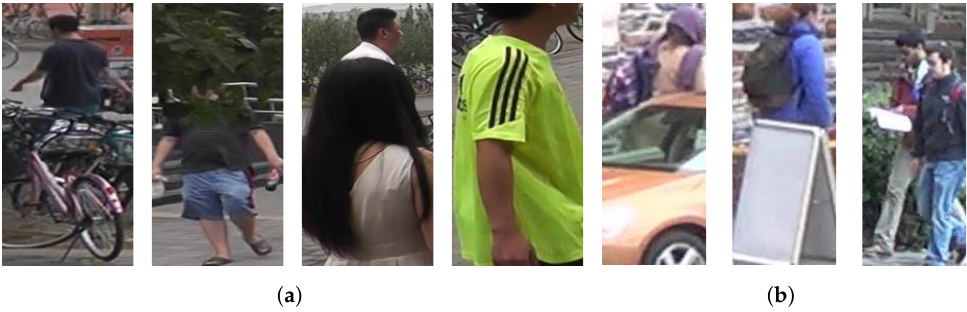
Figure 3. ( a , b ) represent the occlusion types in MARS and DukeMTMC-VideoReID datasets, respec- tively. Various occlusion types exist, such as a lower body or head of a pedestrian occluded by other pedestrians, tracking failure, and so